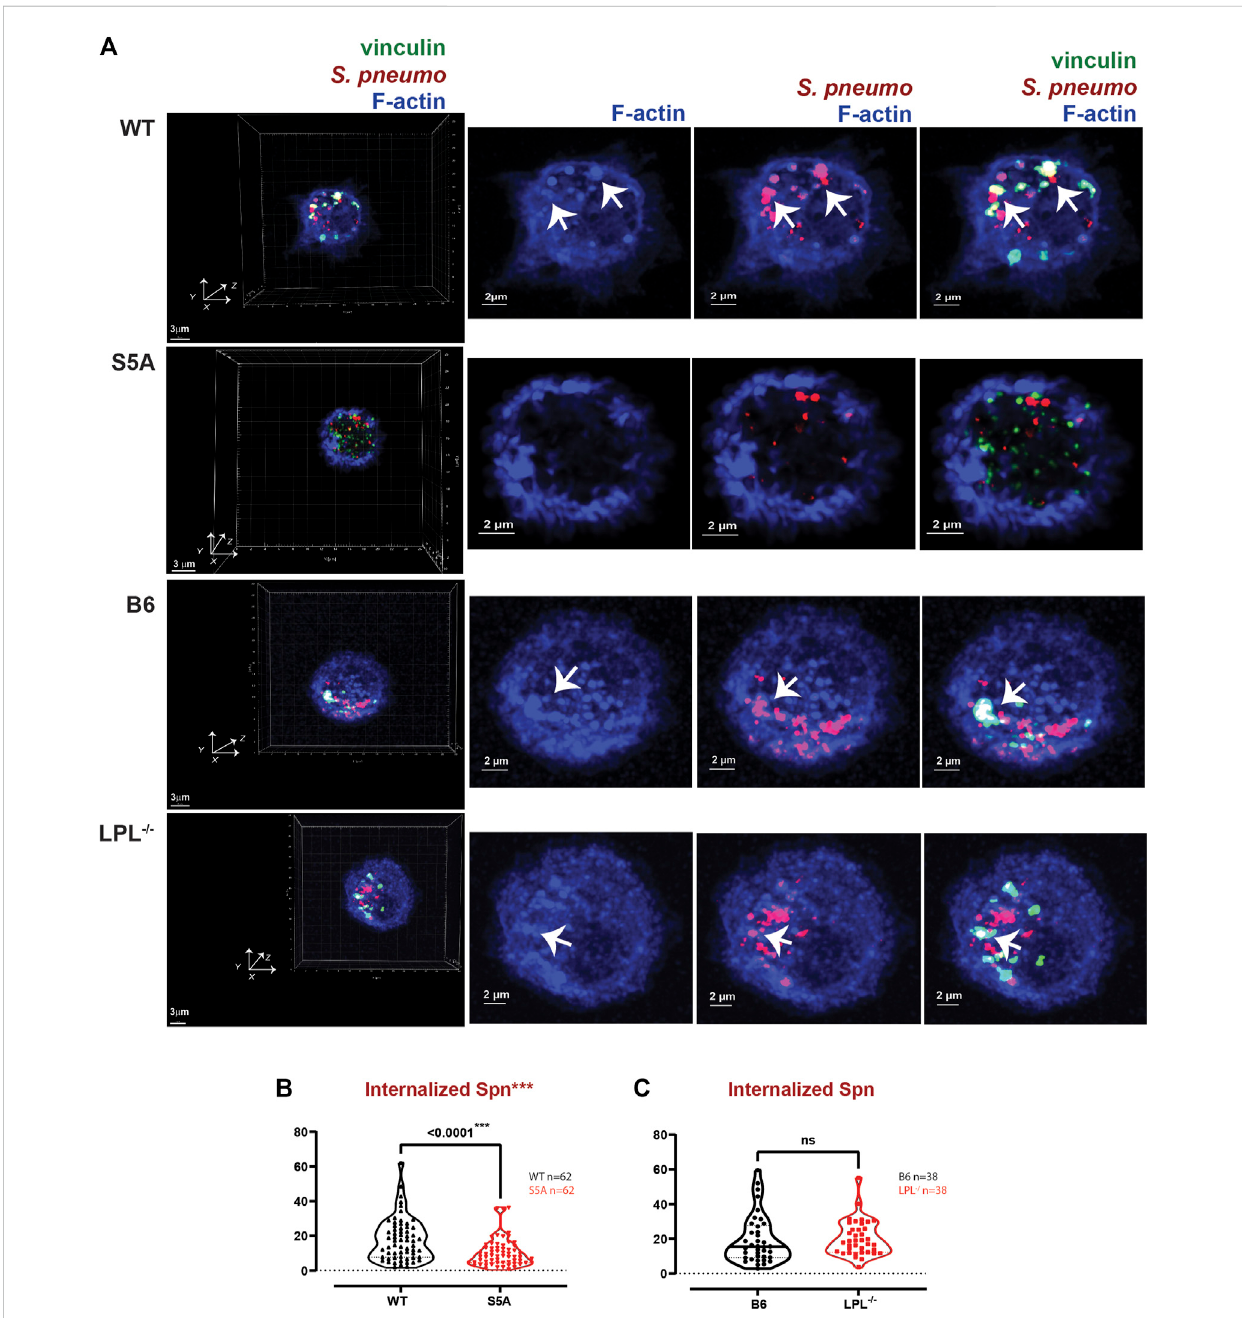
FIGURE 9 Reduced internalization of Spn by AMs derived from S5A mice. (A) Co-localization of vinculin (green), S. pneumoniae (red) and F-actin (blue) in AMs incubated with Spn-RFP for 60 min from matched WT and S5A or matched B6 and LPL − / − mice. Images in left panels show 3D reconstruction of Z-stack confocal micrographs. Other panels are 2D XY projections showing F-actin only, Spn overlaid with F-actin, or overlay of vinculin + Spn + F-actin. PhagosomesincorporateF-actin, Spnandvinculin(white;representativephagosomes indicatedbywhitearrows).Gridsshow2 μ mincrementsand areoptimalforsizeassessment;scalebarsinsubsequentpanelsarederivedfromgrids. (B,C) TotalvolumesofinternalizedaggregatesofSpn,quantifying pneumococcalphagocytosis.Eachsymbolrepresentsthevolumecalculatedfromone fi xedcell;n=numberofcellsanalyzed.Imagesacquiredfromtwo independent experiments. p -values determined by Mann-Whitney; ns = non-signi fi cant; *** p <